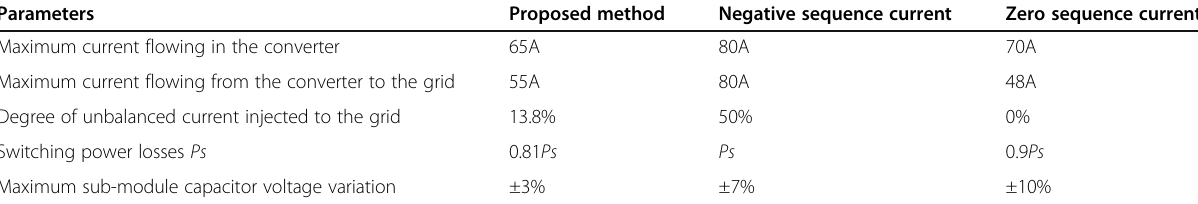
Table 3 comparison of inter-cluster balancing methods